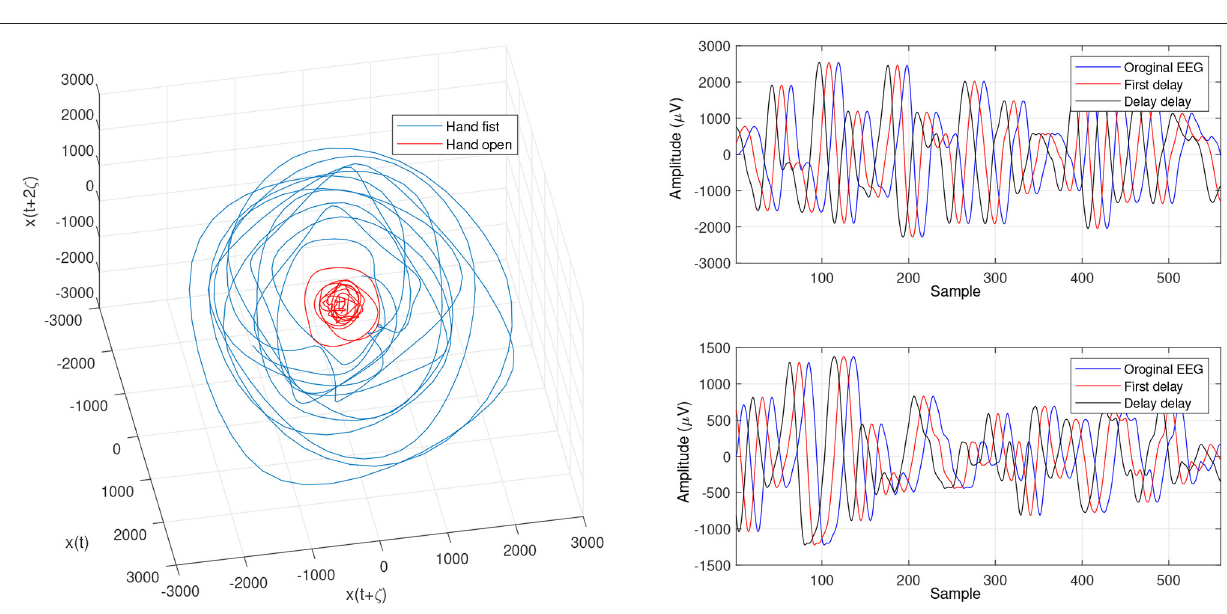
algorithm. Figure 8 shows that the complexity of trajectories in the phase space is reduced significantly and the average accuracy result increased to 72.31%. In the algorithm, the approximated maximum lag for the MI and approximated embedding dimension for the FNN were 96 (valuates between 2 to 96) and 52 (variate between 2 to 52). The obtained results showed that the reconstructed phase space based on